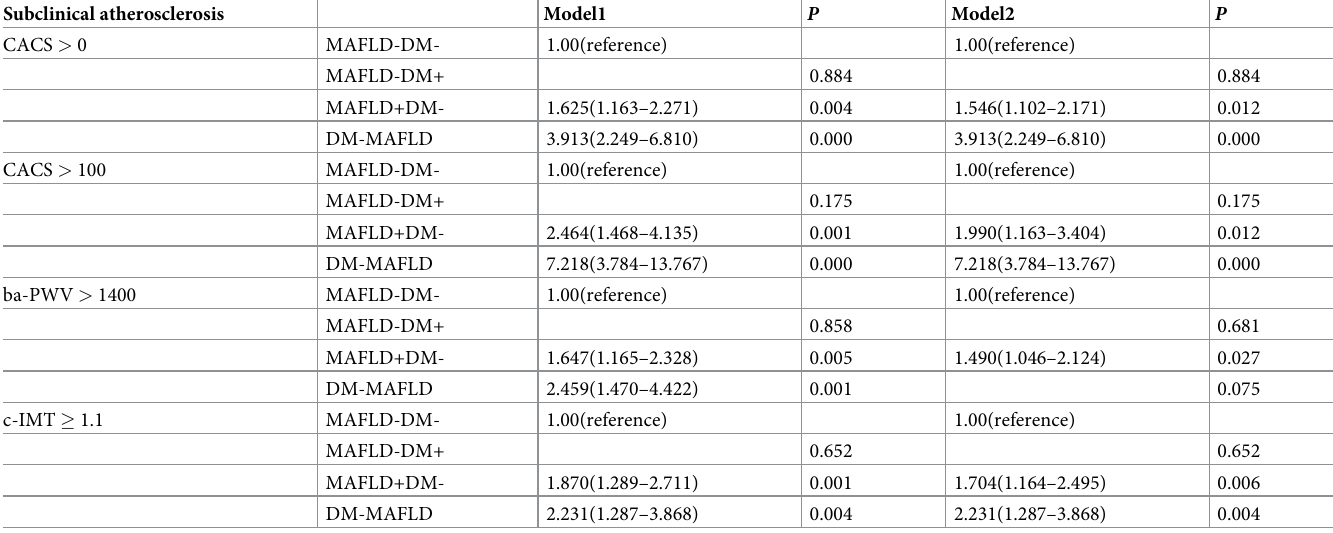
Table 3. The association of subclinical atherosclerosis with combination of MAFLD and/or DM.